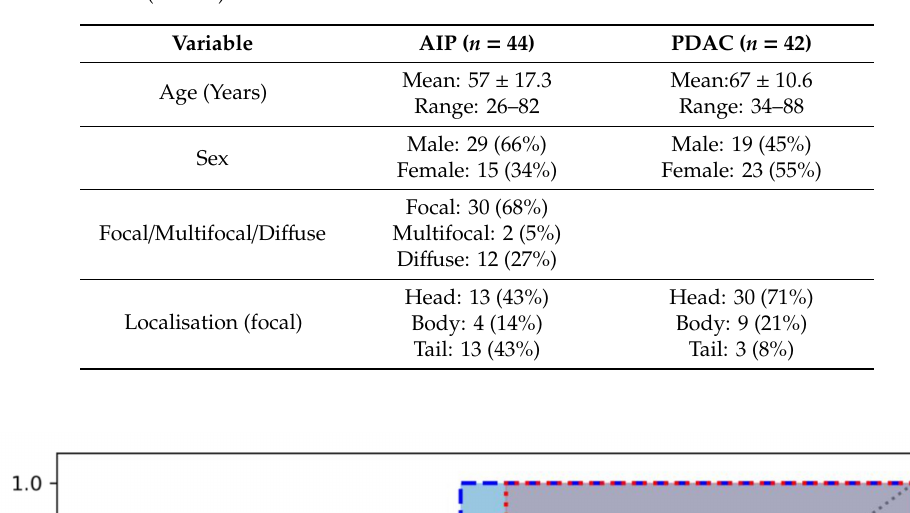
Table 1. Clinical and histological parameters for autoimmune pancreatitis (AIP) and pancreatic ductal adenocarcinoma (PDAC).